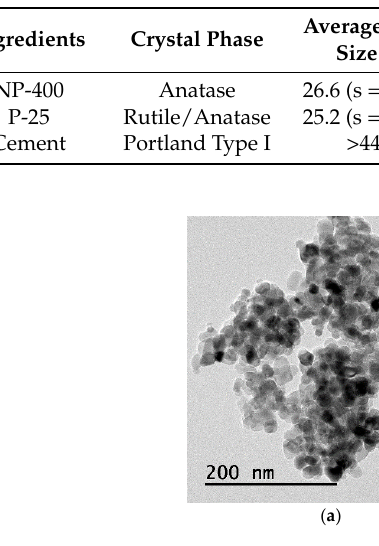
Figure 1. TiO 2 : transmission electron microscope (TEM) images of ( a ) NP-400, Bentech Frontier, Korea; and ( b ) P-25, Evonik,